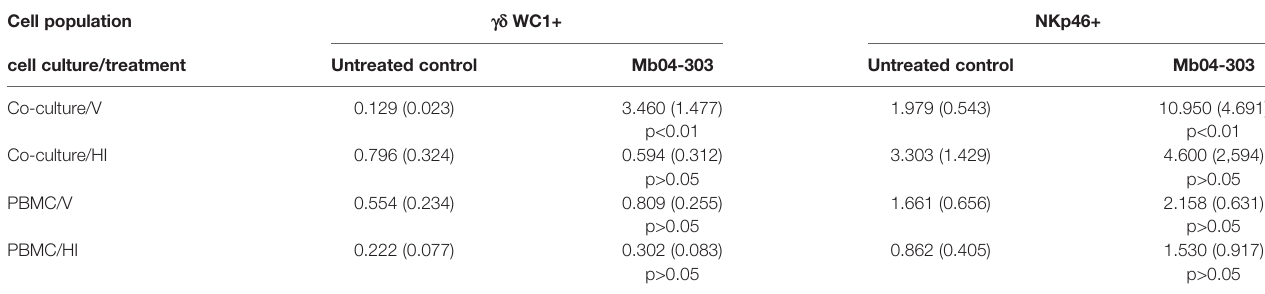
Percentage mean and SEM (between parenthesis) of IFN- g + cells determined by fl ow cytometry in co-cultures or PBMC obtained from fi ve different calves (N=5) treated with heat inactivated bacteria (HI) or viable (V) Mb04-303. For each animal sample and condition tested, a single cell well was analyzed. Mean and SEM values from Figures 4A, B are depicted in the fi rst row (Co-culture/V); the rest of the tested conditions did not induced signi fi cant IFN- g upregulation relative to the untreated control (p values from Friedman test are